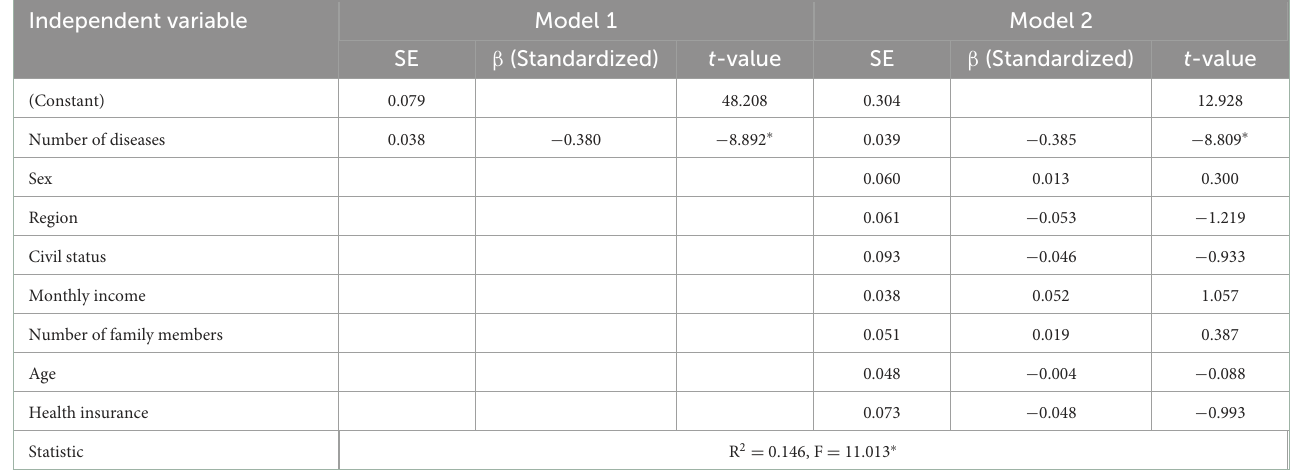
TABLE 6 Factors influencing health satisfaction (Model